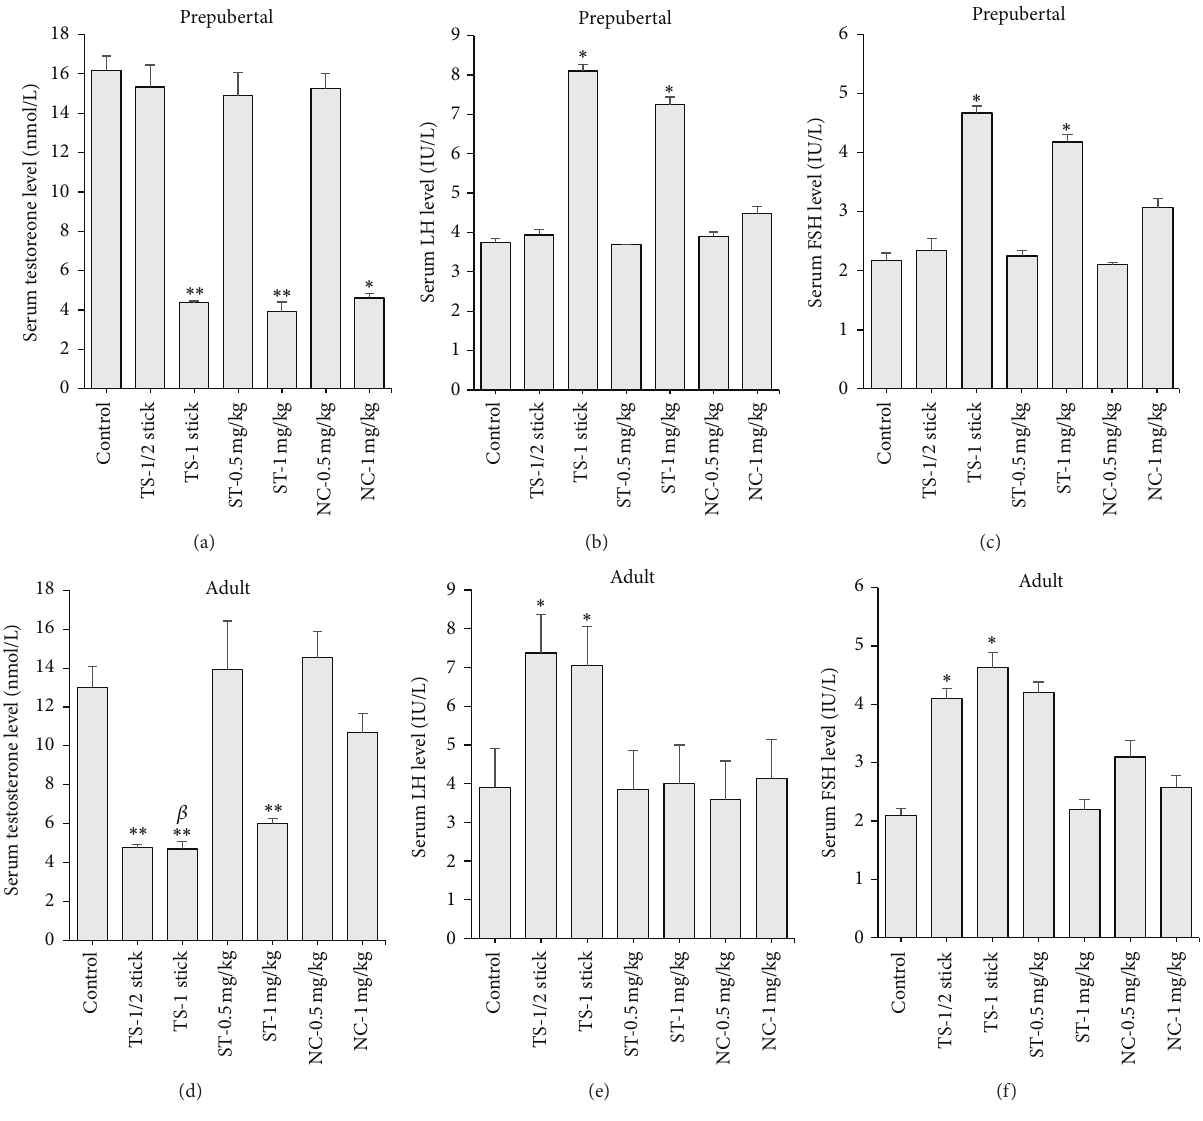
Figure 5: Serum levels of testosterone, luteinizing hormone (LH), and follicle stimulating hormone (FSH) in prepubertal ((a), (b), and (c)) and adult rats ((d), (e), and (f)) following daily exposure to cigarette smoke (tobacco smoke, TS), smokeless tobacco (ST), and nicotine for 30 days. Data are expressed as mean ± SEM ( 𝑛 = 6 ). ∗ 𝑝 < 0.05 compared to control; ∗∗ 𝑝 < 0.01 compared to control; 𝛽 𝑝 < 0.05 compared to